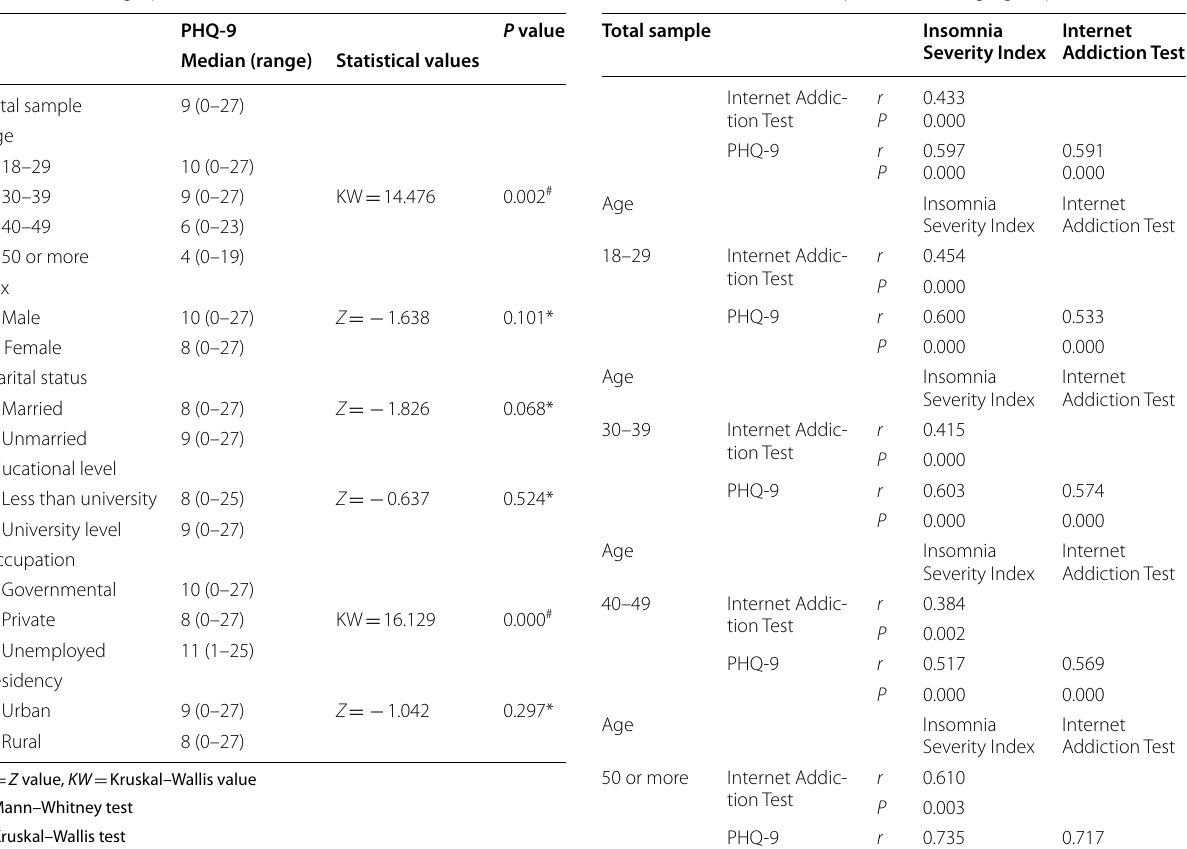
Table 5 Relation between Patient Health Questionnaire (PHQ9) and sociodemographic data